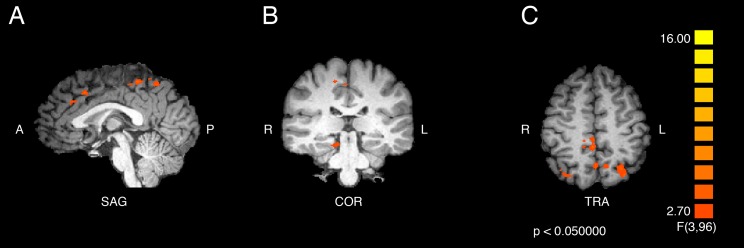
Activation from the interaction of participant group and video type.Regions of significant differential activation for the effect of the interaction between participant group (ASMR, control) and video type (ASMR-eliciting, control videos) include bilateral superior parietal, right cerebellum and paracentral lobule, and left cingulate, medial prefrontal, precentral, and inferior frontal gyri and precuneus. (A) Sagittal view. (B) Coronal view. (C) Transverse view. Results displayed at p < 0.05, cluster threshold corrected at 10 voxels. SAG, sagittal; COR, coronal; TRA, transverse; A, anterior; P, posterior; R, right; L, left.